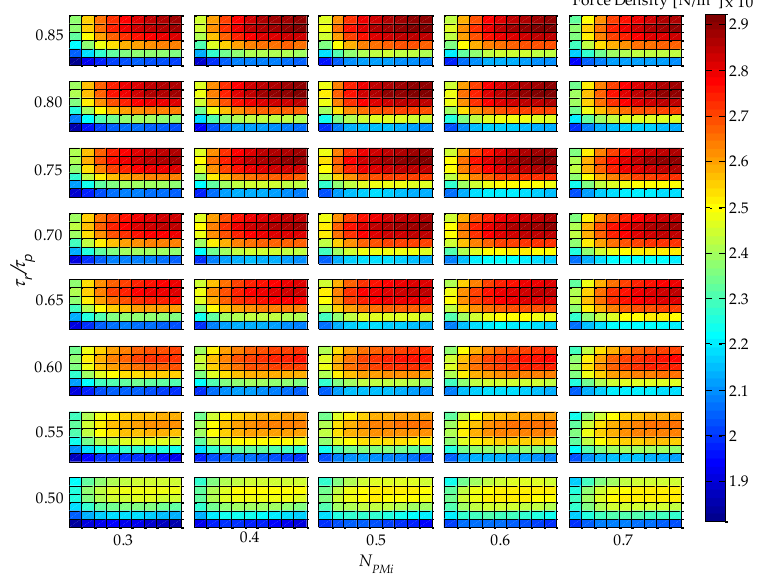
Figure 4. Results of force density for J rms = 3 A/mm 2 and θ e = π/6, of the uncoupled design for four parametric variables: τ r / τ p , N PMi , N CPMs , and n form .